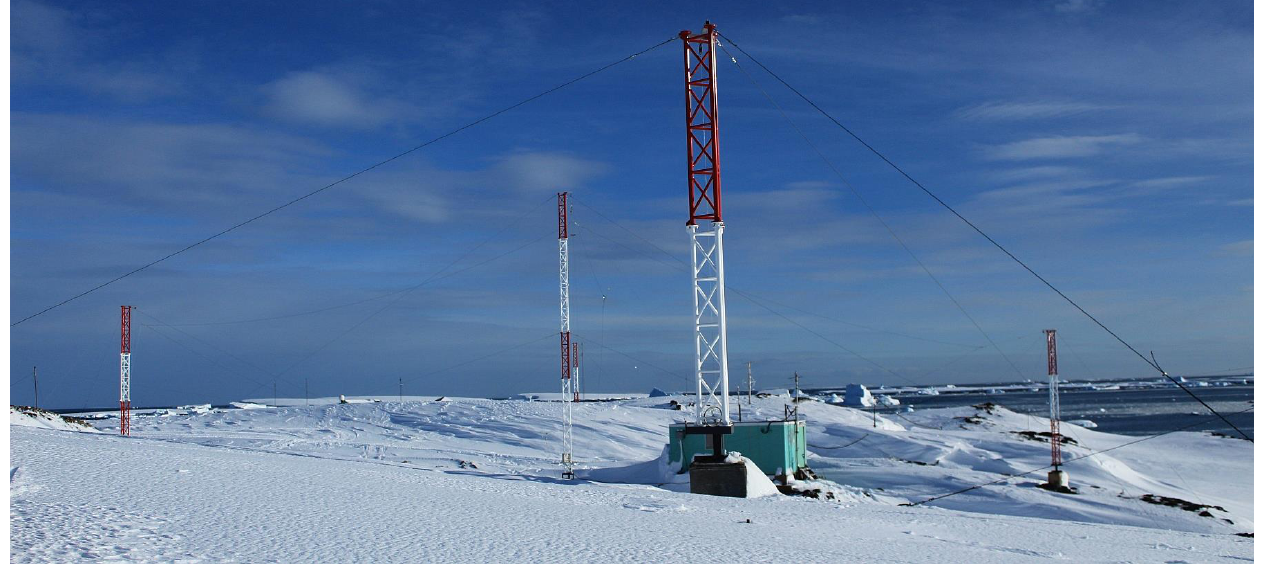
Figure 4. Antenna system of passive ionosonde at UAS.